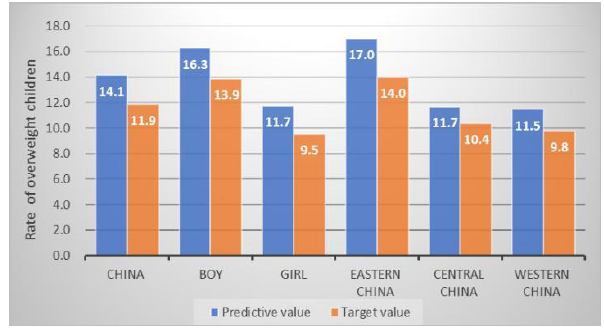
Figure 3. The estimated rate of Chinese overweight children and SDG target in 2025 (%). Int. J. Environ. Res. Public Health 2020 , 17 , x